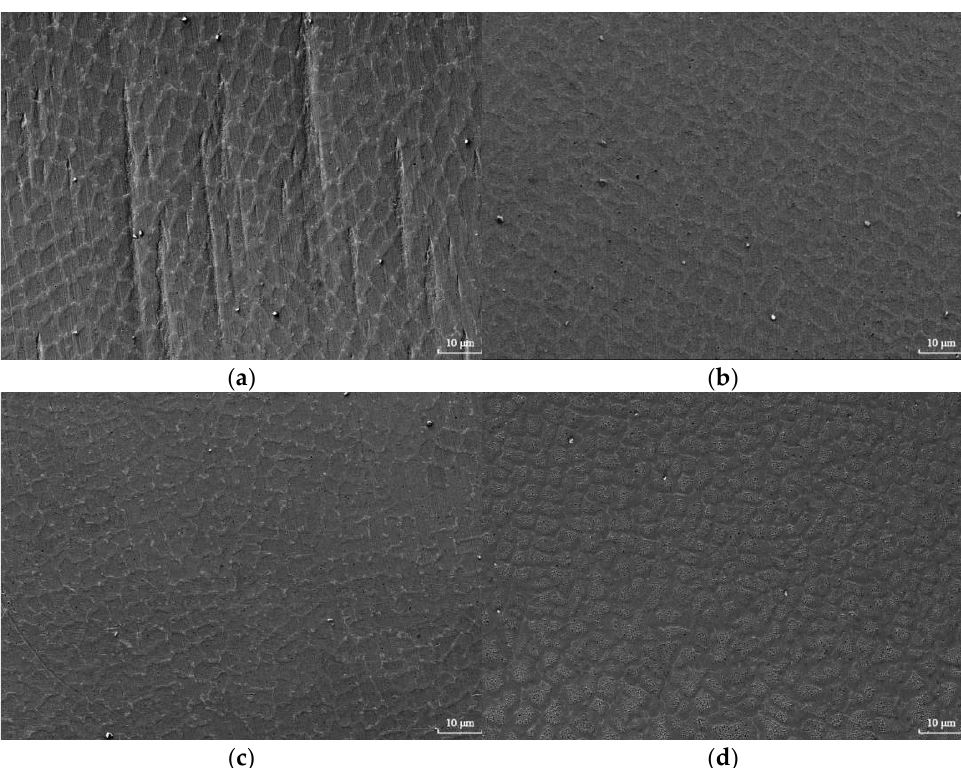
Figure 10. Microstructure in the top region of the laser-UHF induction hybrid deposited layers under current density of ( a ) 1.01 × 10 8 A/m 2 ( b ) 1.14 × 10 8 A/m 2 ( c ) 1.27 × 10 8 A/m 2 ( d ) 1.40 × 10 8 A/m 2.